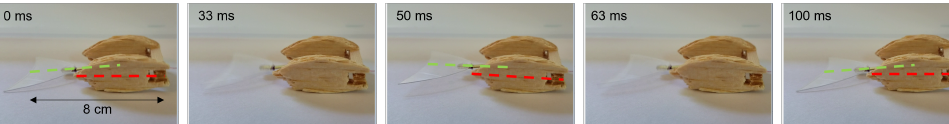
Figure 15. ( a ) Schematic illustration of fish robot, showing impact amplification structure relative to manually carved balsa wood frame; ( b ) enclosing elements for operation in water, with polyethylene wrap and modeling clay ballast; ( c ) overhead images captured near maximum oscillation when partially-immersed in water, with approximately 1.5 degree bend angle.